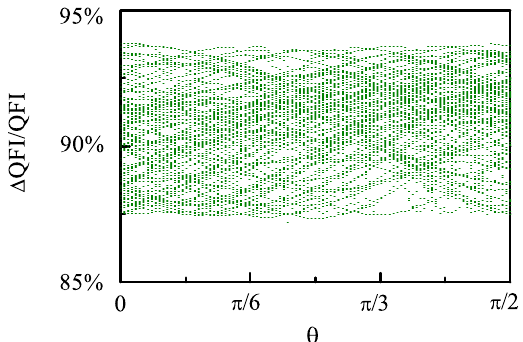
Figure 3. The percent decrease of QFI when a weak resonant oscillating field orthogonal to the geomagnetic field is applied, i.e., ∆ QFI/QFI , as a function of the direction angle θ for 100 randomly sampled initial states of RP